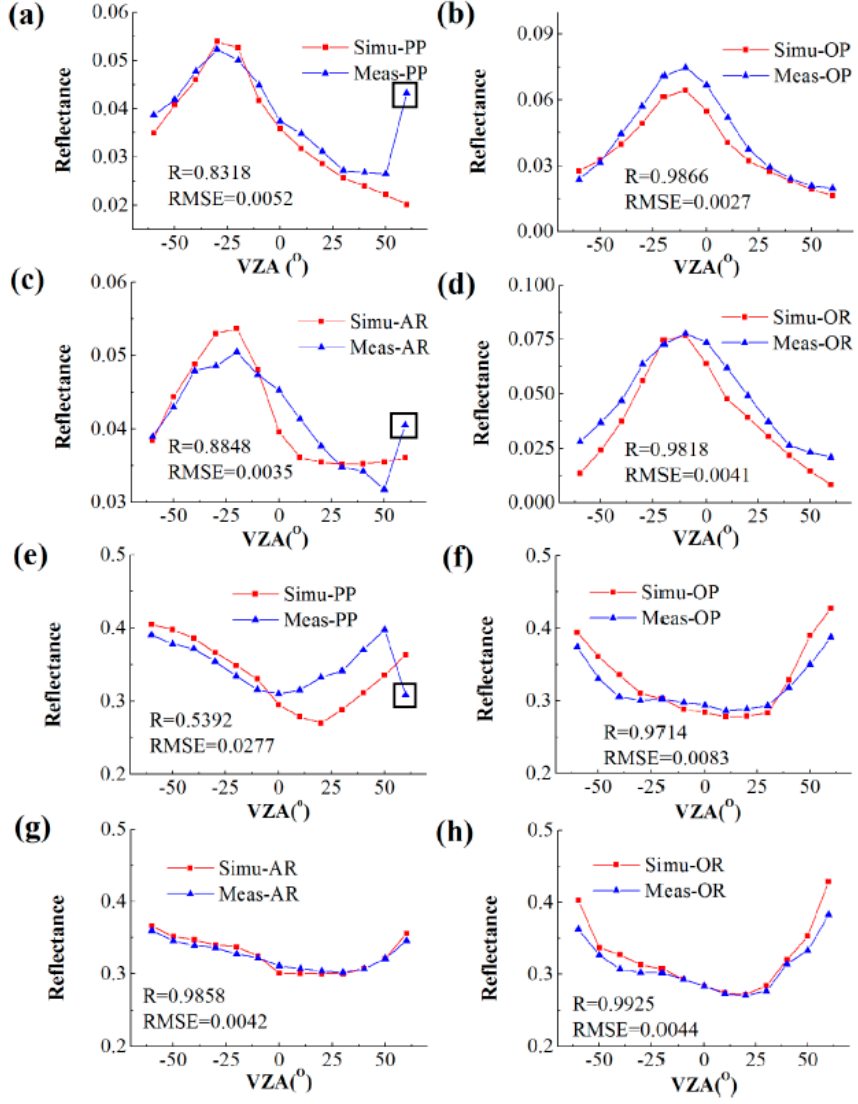
Figure 11. Comparison of the distribution of the sum of the reflectance simulated by the row model and field data in the multiangle observation for the principal plane (PP) mode ( a , e ), orthogonal plane (OP) mode ( b , f ), along-row plane (AR) mode ( c , g ), and orthogonal row plane (OR) mode ( d , h ). ( a – d ) Red band (670 nm); ( e – h ) NIR band (860 nm). VZA is the viewing zenith angle. The black box is the abnormal point in the measurement.